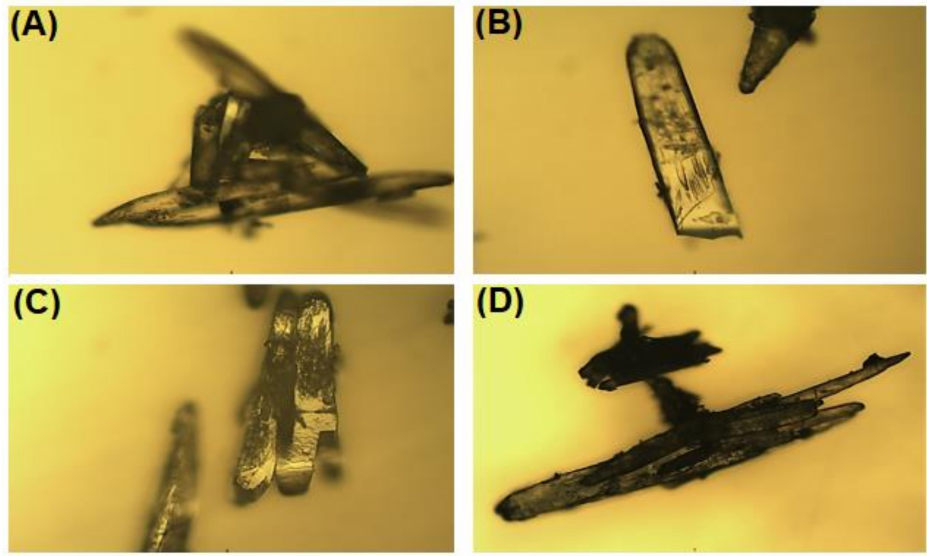
Figure 1. Microscopic analysis of piperine crystals. In ( A – D ), we have the representation of the large and rectangular crystals of the piperine.